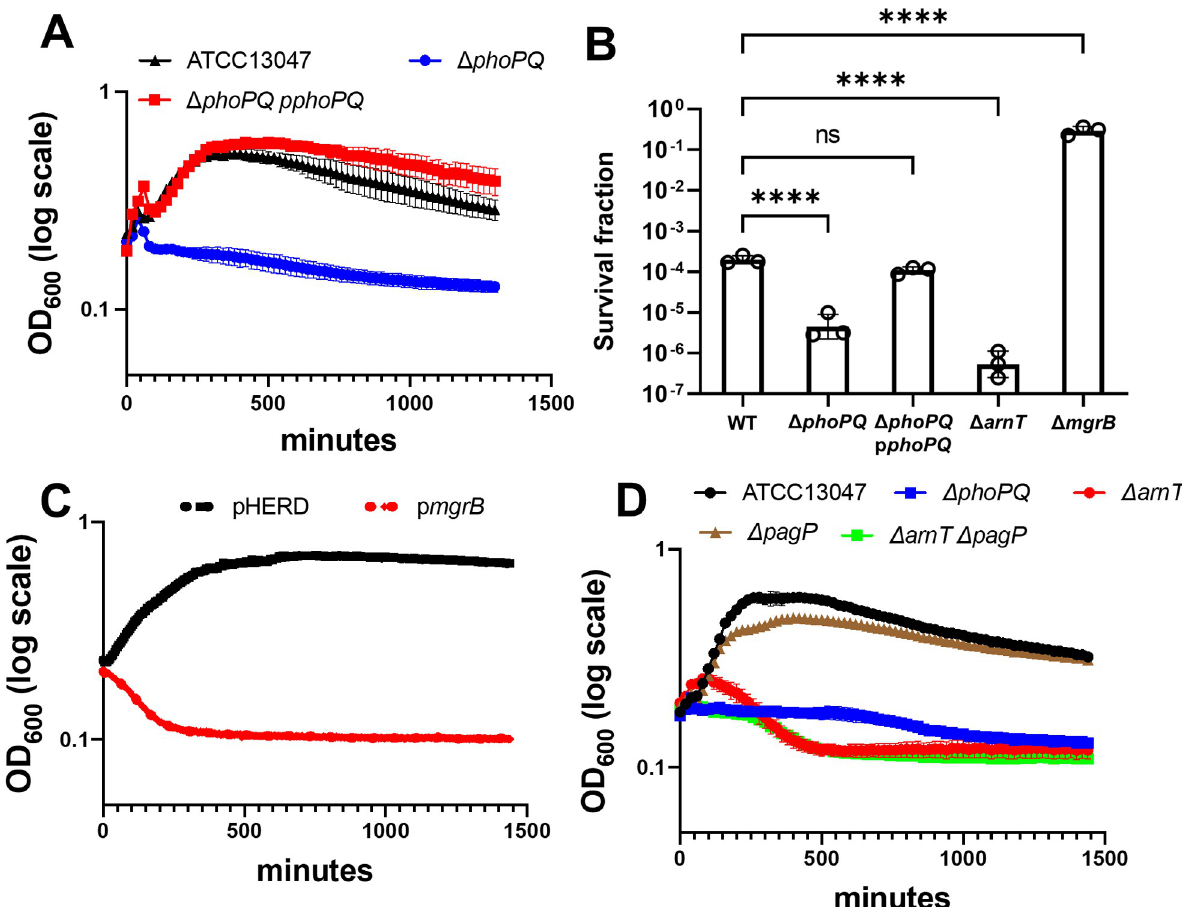
Fig 2. The PhoPQ system promotes meropenem tolerance in E . cloacae . (A) Spheroplast formation in response to meropenem treatment. Overnight cultures were diluted 10-fold into fresh LB medium containing 10 μ g/mL meropenem and OD 600 was measured. (B) Fraction of population surviving after 24 hours of meropenem exposure from experiments as described in (A). (C) MgrB overexpression reduces tolerance. Cells were treated as described in (A), but with the addition of 0.2% arabinose (inducer). pHERD; empty vector. (D) The arn operon is required for meropenem tolerance. Experiments were conducted as described in (A). Data in each graph represent the average of 3 replicates +/- standard deviation; additional biological replicates are shown in S2B Fig . Statistical significance for survival fraction determined by one-way ANOVA of log transformed data, followed by Tukey’s correction for multiple comparisons (ns, not significant; ���� , p � 0.0001).